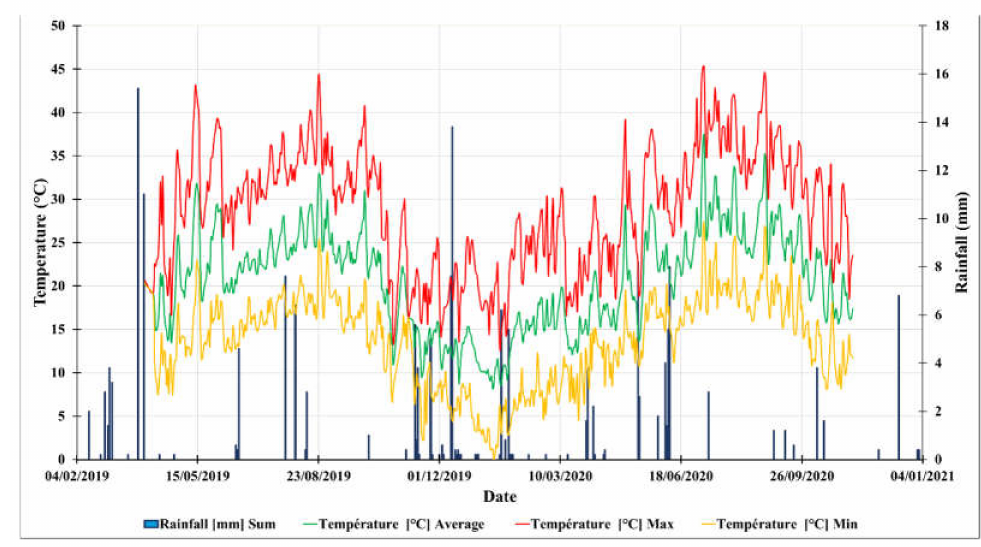
Figure 7. Rehamna climatic conditions taken from the UM6P Experimental Farm meteorological station.